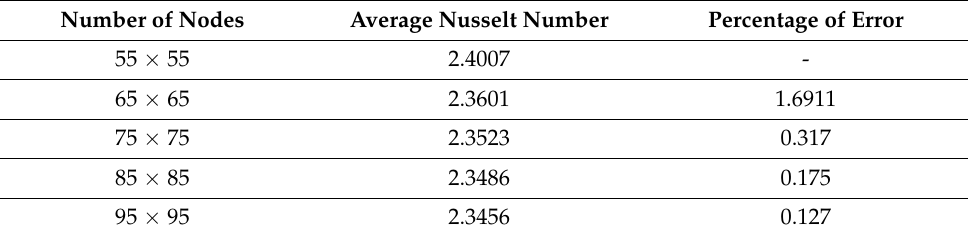
Table 2. Effect of the mesh size on the average Nusselt number for Gr = 100, Ri = 1, and = 0.05, φ = φ Al 2 O 3 Cu